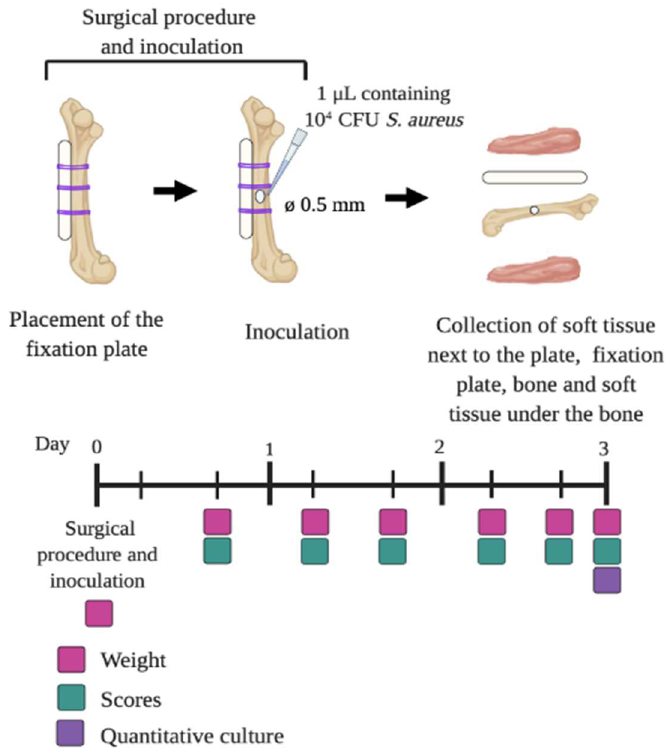
Figure 3. Schematic representation of the in vivo surgical procedure.